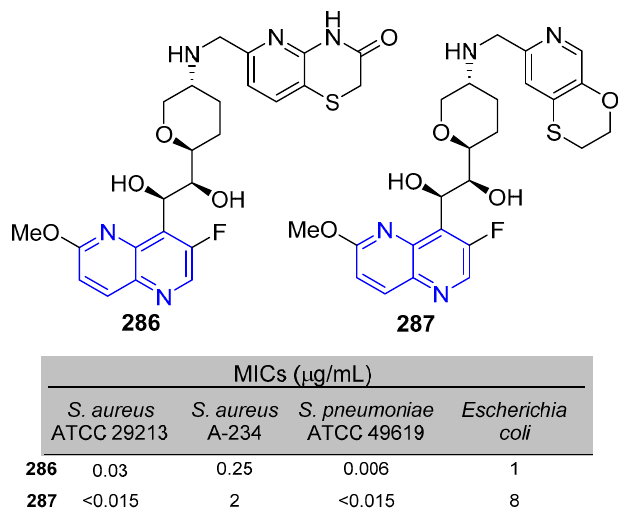
Figure 17. Antibacterial activity of THP-naphthyridine derivatives.